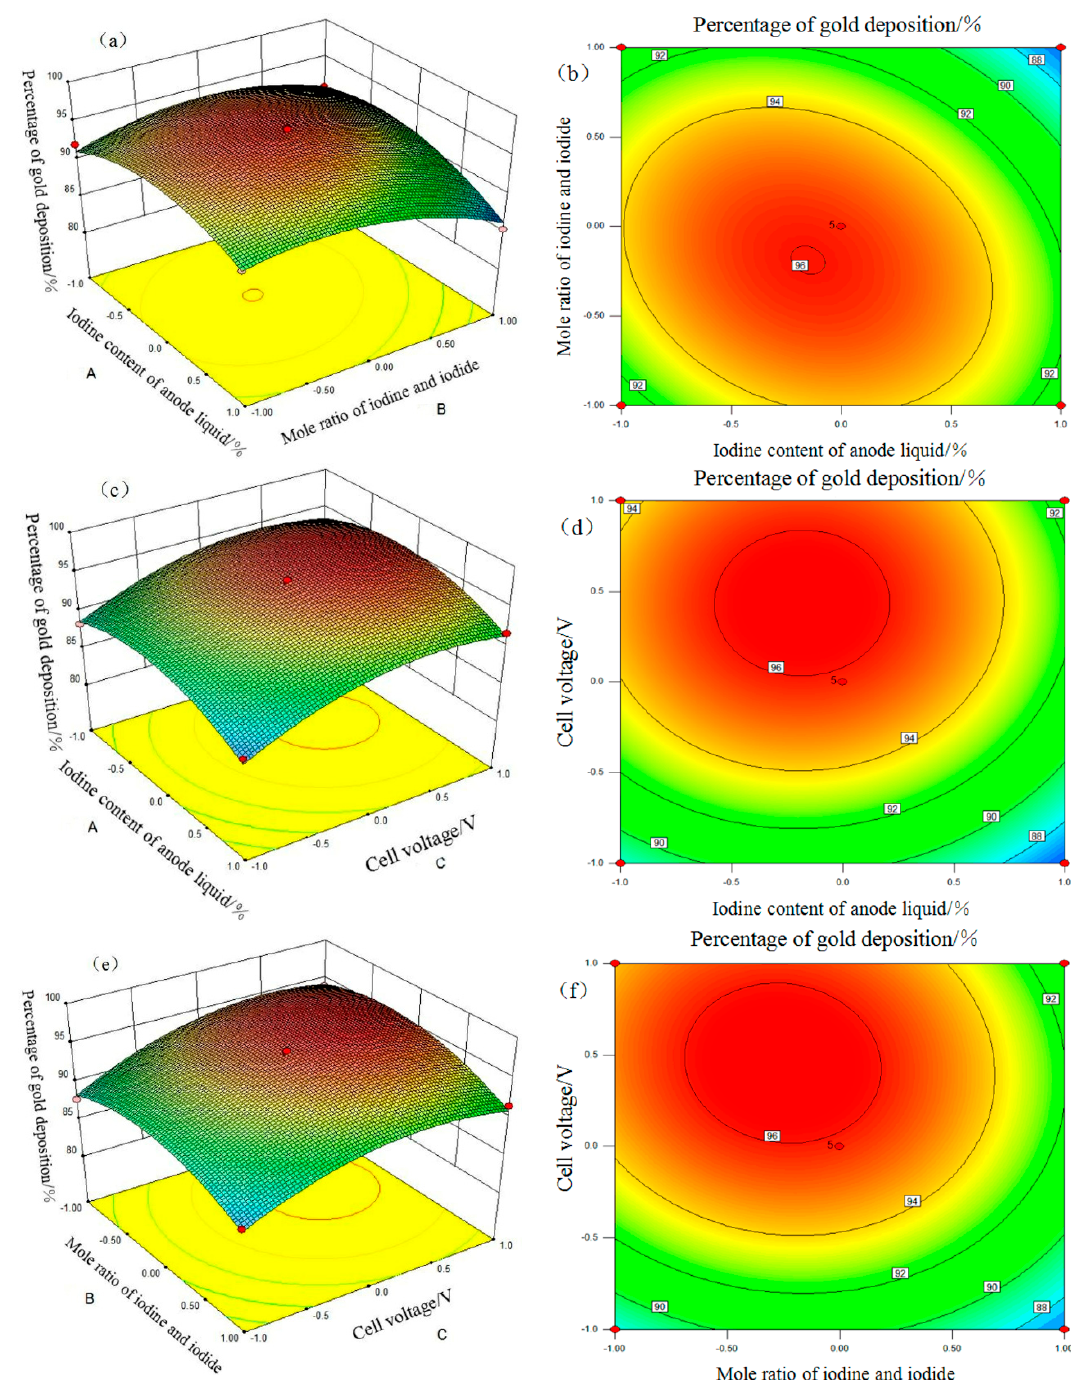
Figure 7. Response surface and contour map for percentage of gold deposition. ( a ) AB response surface, ( b ) AB contour map, ( c ) AC response surface, ( d ) AC contour map, ( e ) BC response surface, and ( f ) BC contour map.